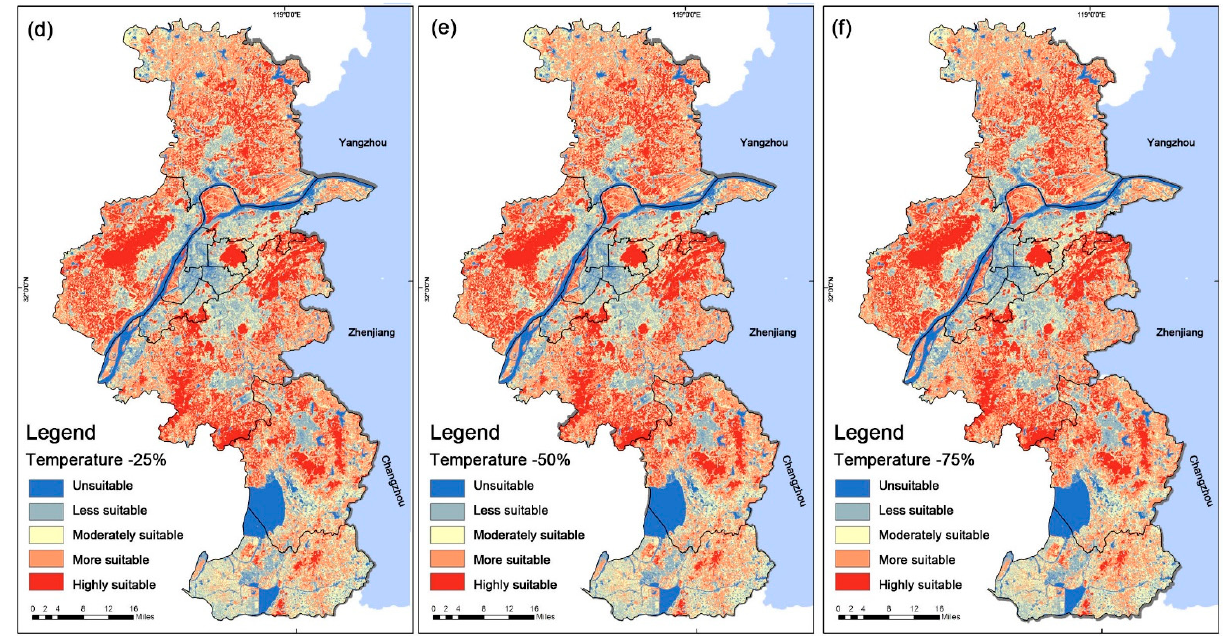
Figure 8. Results from sensitivity analysis from GIS for the criterion ‘temperature’ regarding About City Park Site Selection analysis: ( a ) Temperature 25%, ( b ) Carbon 50%, ( c ) Carbon 75%, ( d ) Temperature − 25%, ( e ) Temperature − 50%, ( f ) Temperature − 75%.